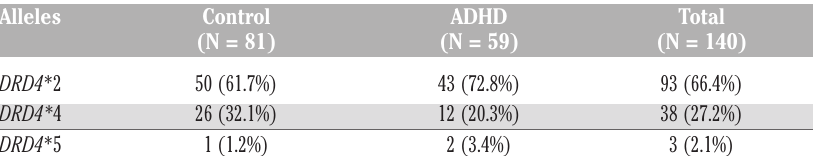
Table 4. Frequency of the DRD4